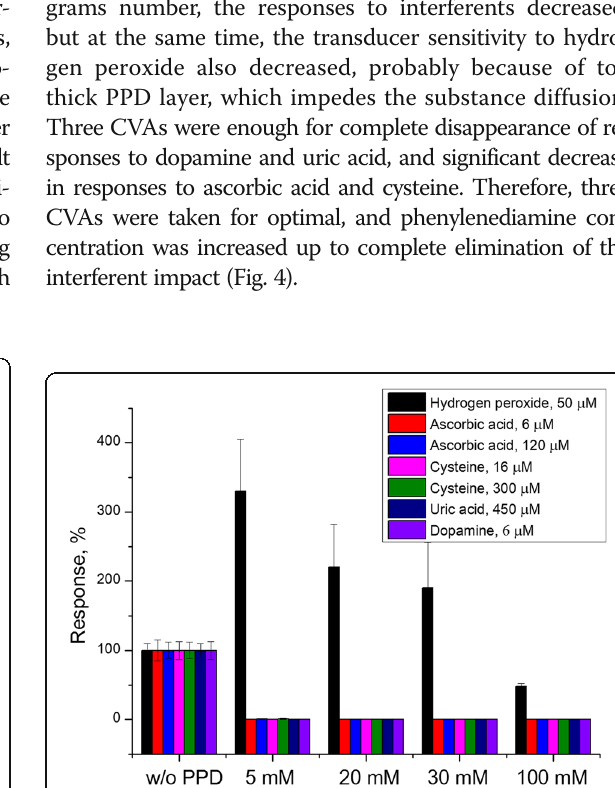
Fig. 2 UV-vis diffuse reflectance spectra of m -phenylenediamine and PPD membrane, formed on the Pt electrode